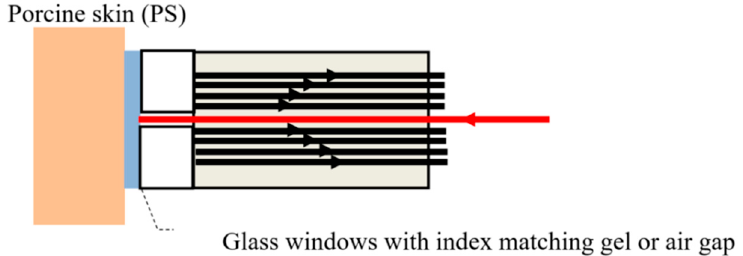
Figure 2. Fiber array with glass window and index-matching gel (IMG) or air gap, in front of the signal fibers and extended source fiber.